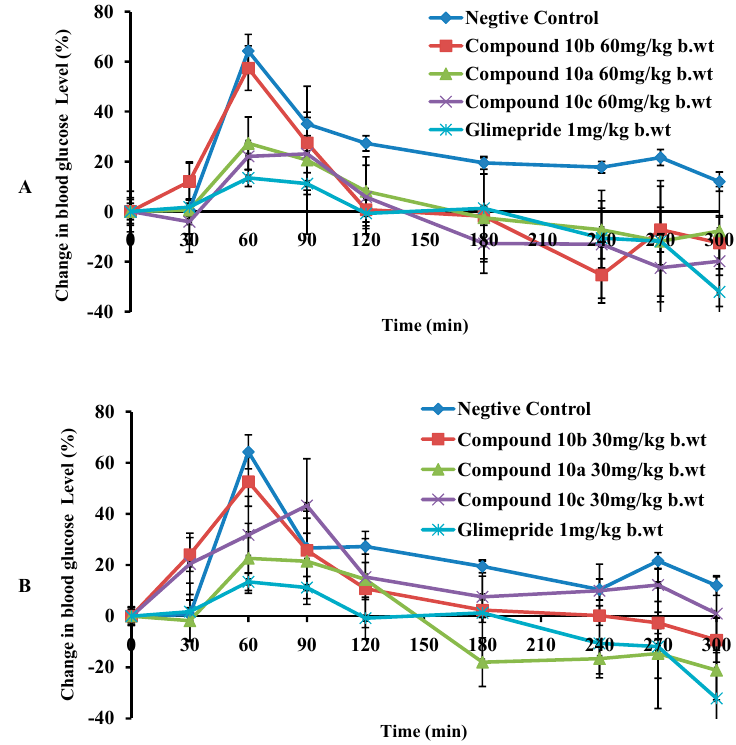
Figure 2. Change in blood sugar level in fasting normal mice. ( A ) 10a – c (60 mg/kg b.wt); ( B ) 10a and 10b (30 mg/kg b.wt). Each bar results are the mean ± SEM for n = 5–8 rats per treatment group.